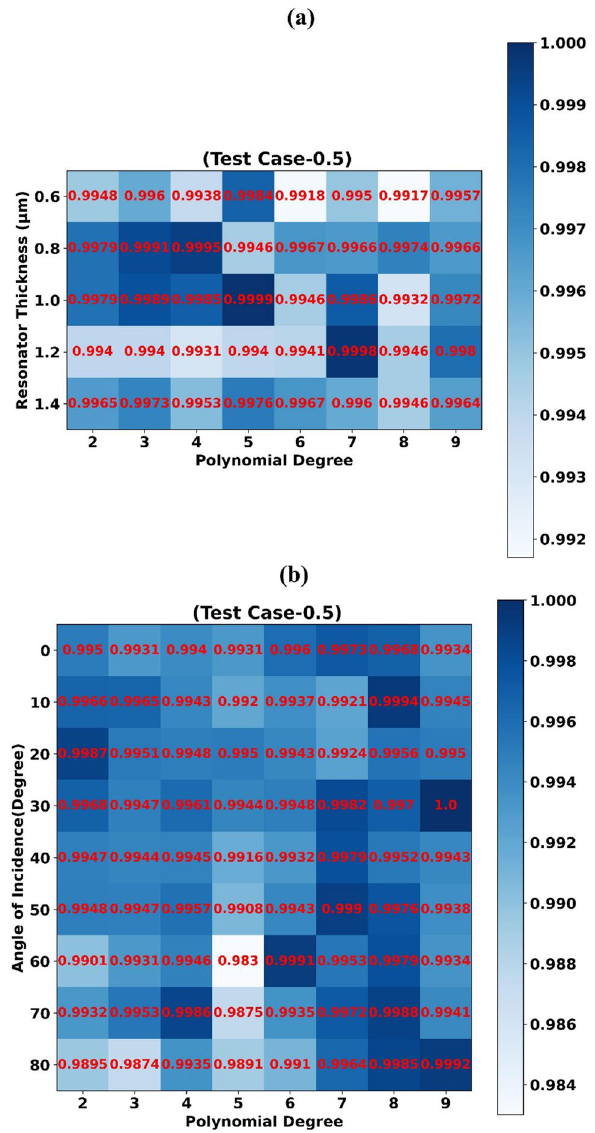
Figure 6. Prediction accuracy (R 2 Score) of 1D-CNN Regressor models trained for assorted values of ( a ) Resonator thickness and polynomial degree features (Test Case C-0.5) ( b ) Angle of incidence and polynomial degree features (Test Case